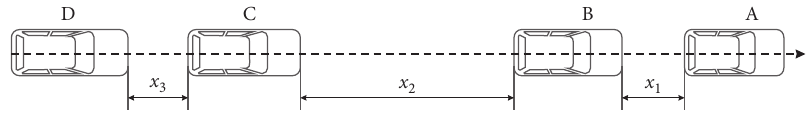
Figure 9: Initial relative position of single-lane vehicle